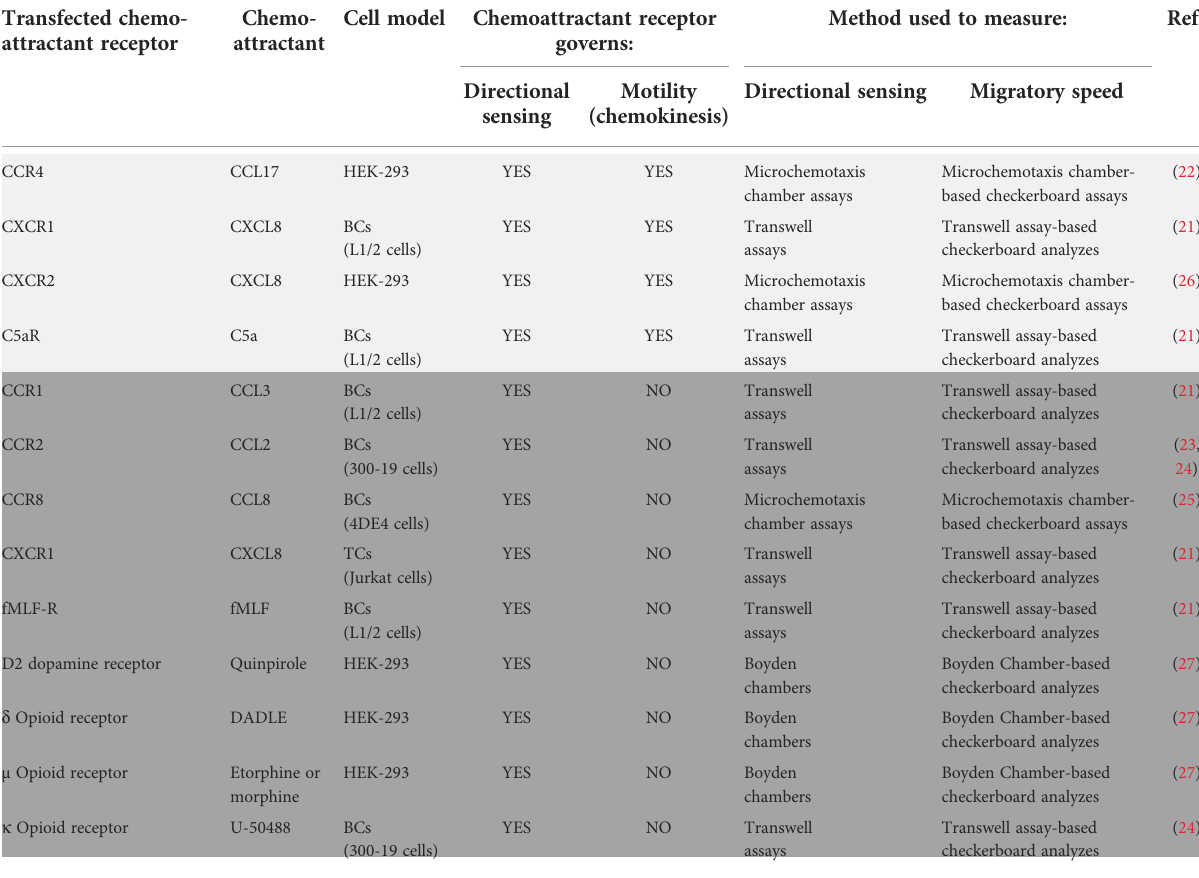
TABLE 1 Ability of transfected chemoattractant receptors to control